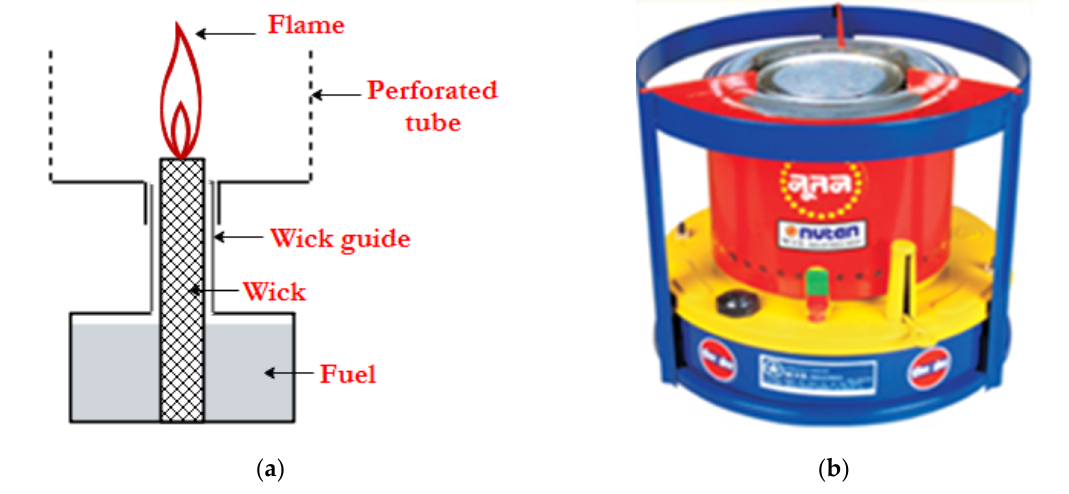
( b ) Figure 5. Schematic of pre-vaporizing type ( a ) burner and ( b ) cook-stove.